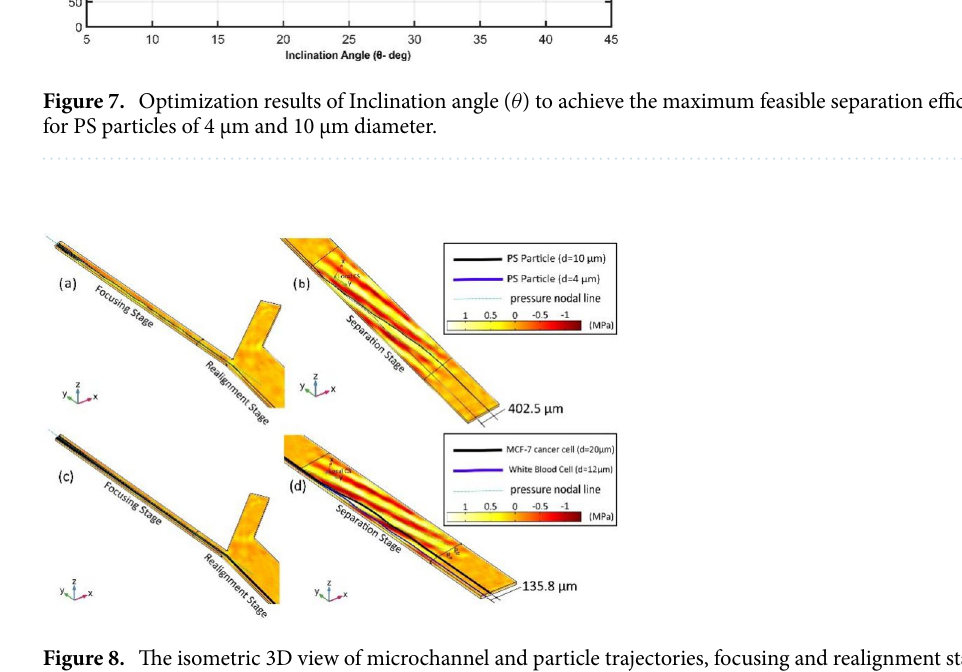
Figure 8. The isometric 3D view of microchannel and particle trajectories, focusing and realignment stage of (a) PS particles (10 V driving voltage), and (c) WBCs and MCF-7 cancer cells (5 V driving voltage), separation stage of (b) PS particles (40 V, θ = 10°), and (d) WBCs and MCF-7 cancer cells (30 V, θ =